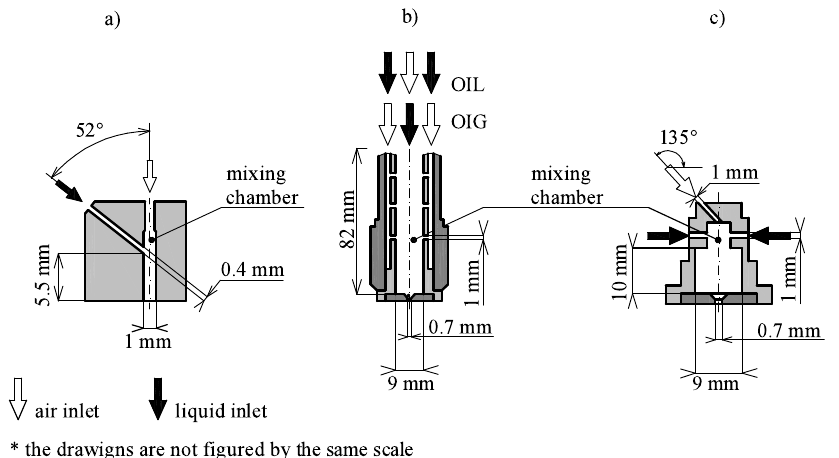
Figure 1. The atomizers geometry, ( a ) Y-jet atomizer, ( b ) OIL and OIG atomizers, ( c ) CFT